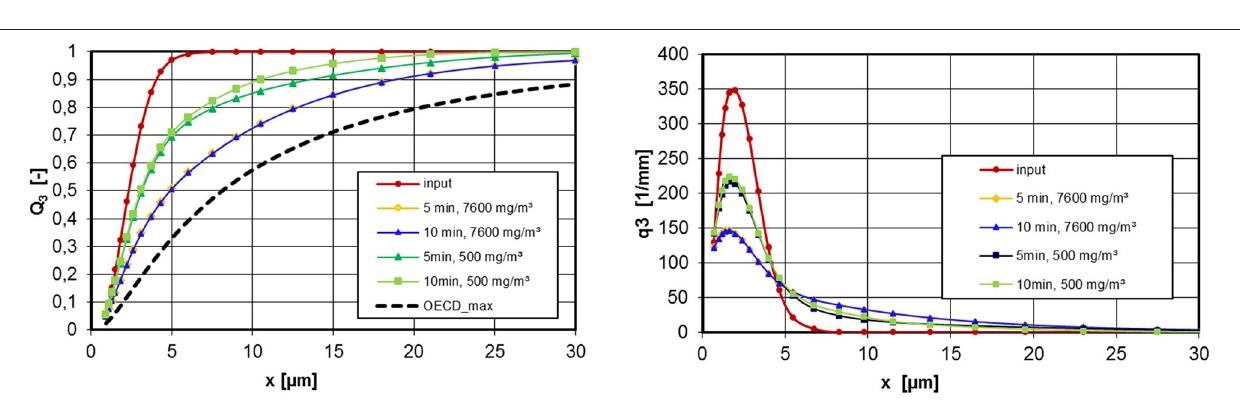
investigated in this study, it has been shown that concentrations up to 500 mg/m 3 was technically